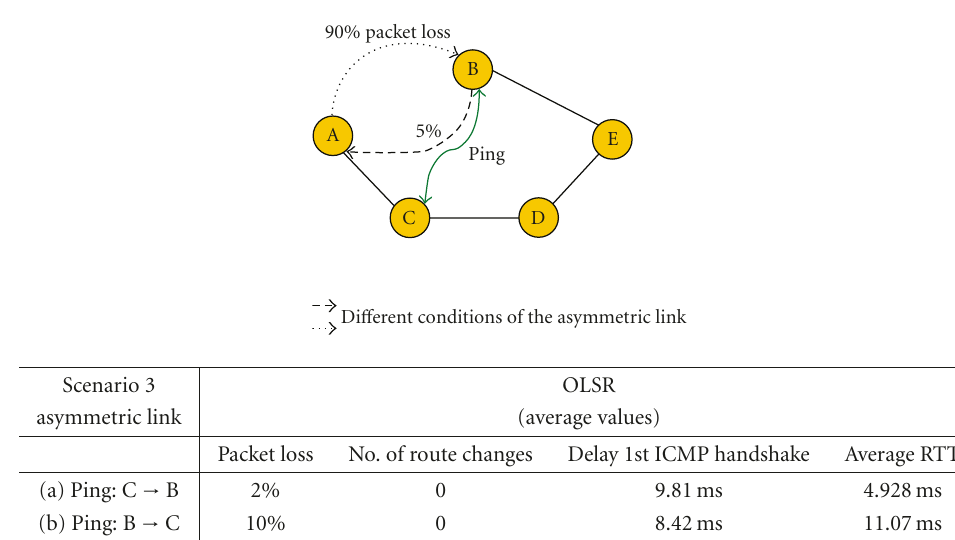
Figure 11: Asymmetric links: AODV performance on scenario 3.